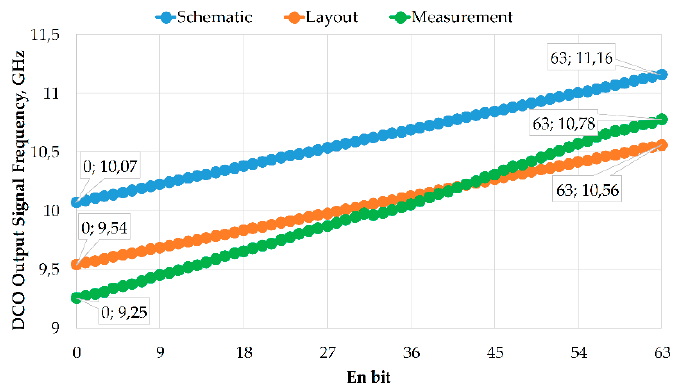
Figure 6. Tuning range of the proposed LC DCO.